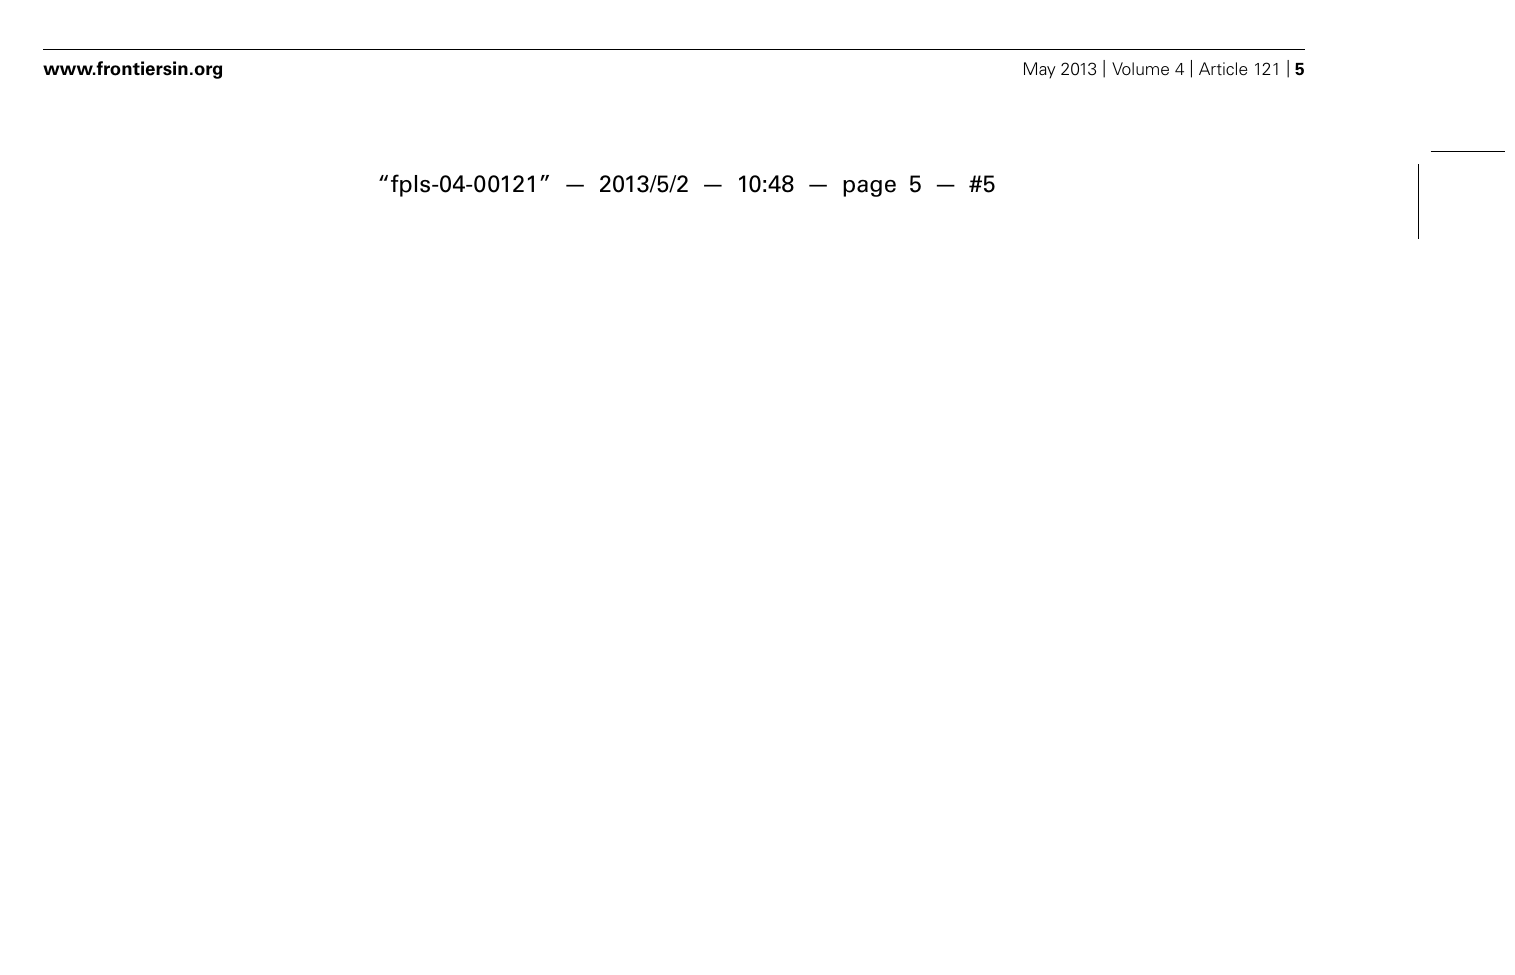
35S::LeT6 tobacco plants. (D) Total lignin content in water control and GA3 treated onWt and transgenic 35S::LeT6 and 35S::Kn1 tobacco plants. Error bars represent standard error ( ± SE; N = 4). Scale bars = 5 cm (A – C) .